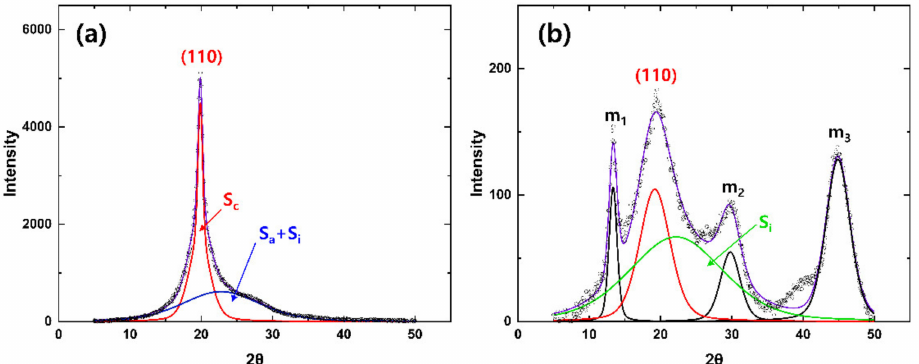
Figure 8. Peak resolution of ( a ) equatorial and ( b ) meridional intensity profiles extracted from the 2D-WAXD patterns of the L-50K-20 as-spun